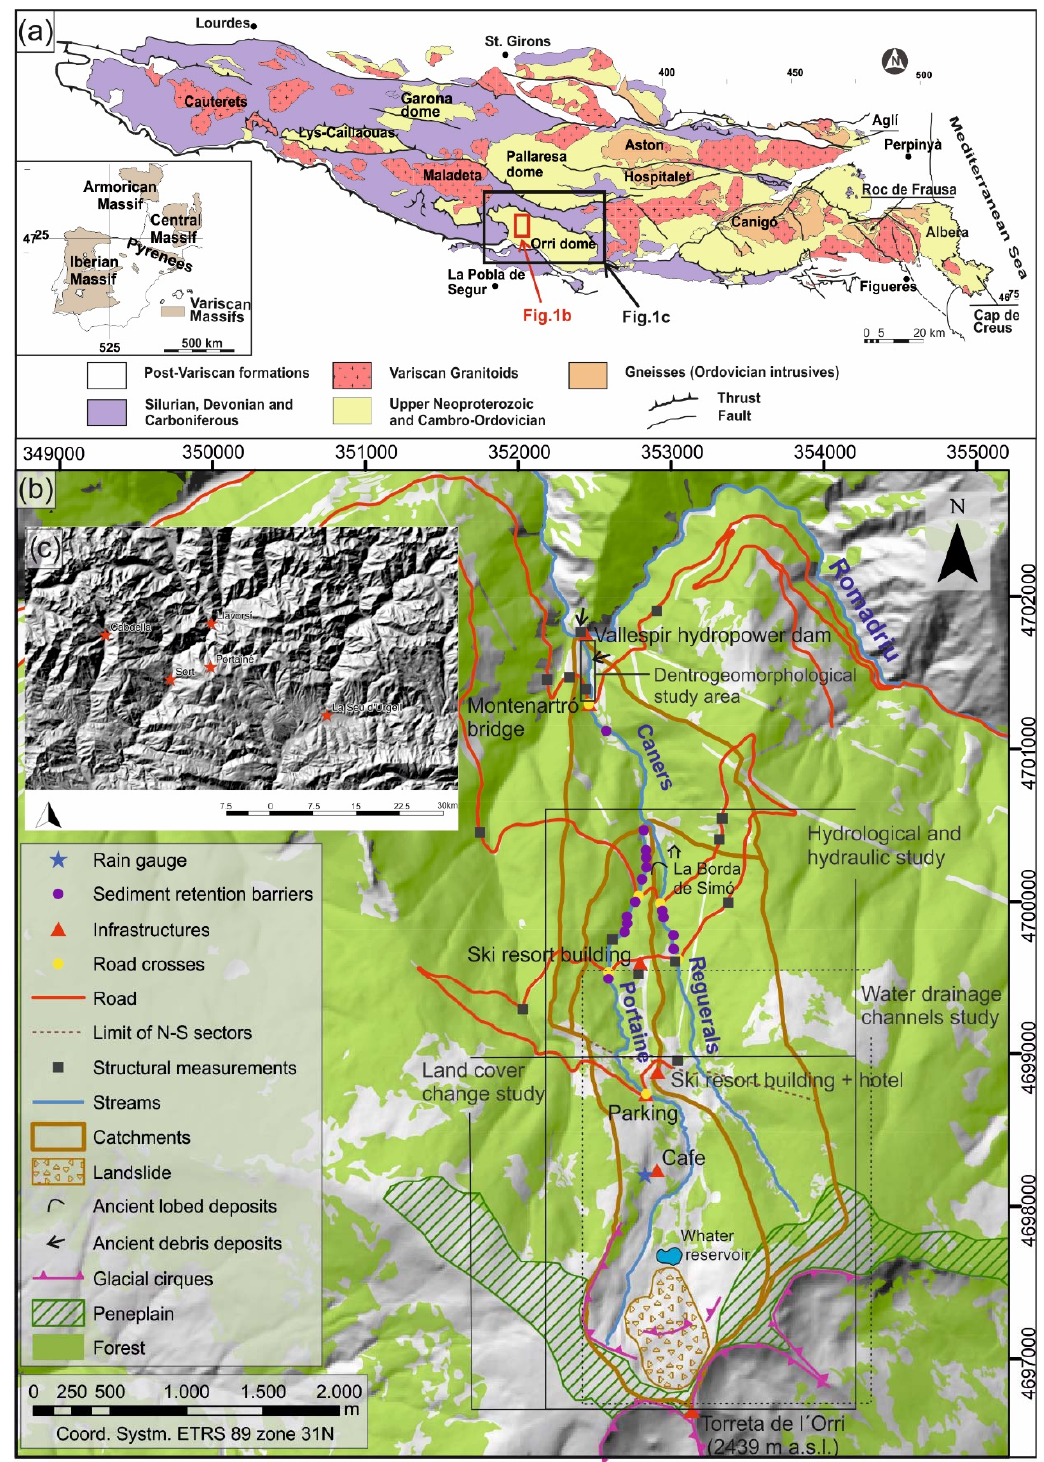
Figure 1. Study area: ( a ) Geographic and geological location of the Axial Pyrenees; Pre-Variscan materials, on which the study area is located, stand out. ( b ) Geomorphological setting and delineation of the Portain é drainage basin, including sub-areas of the study; specific location of studied sediments and anthropogenically significant elements cited throughout the article. ( c ) Locations of the rain gauges used in this study.